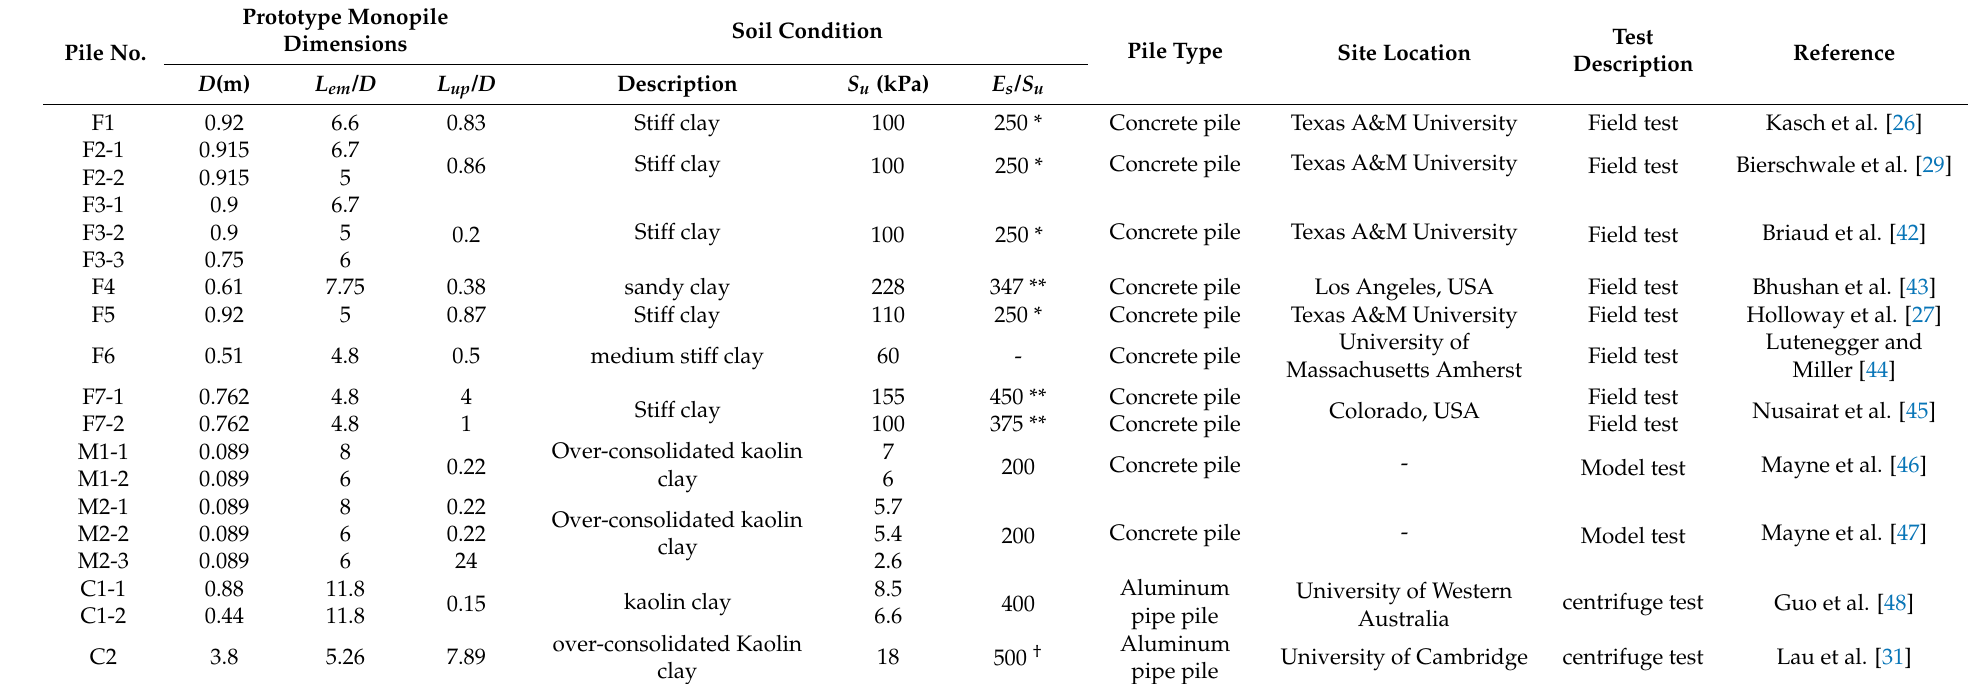
Table 2. Details of laterally loaded pile